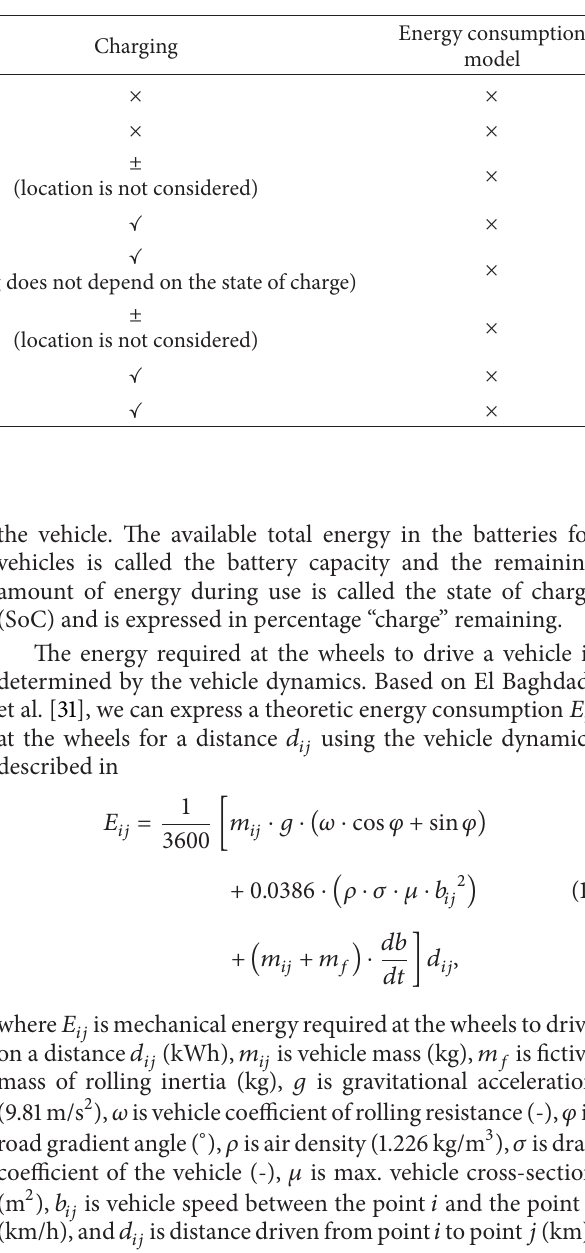
Table 1: Overview of the literature